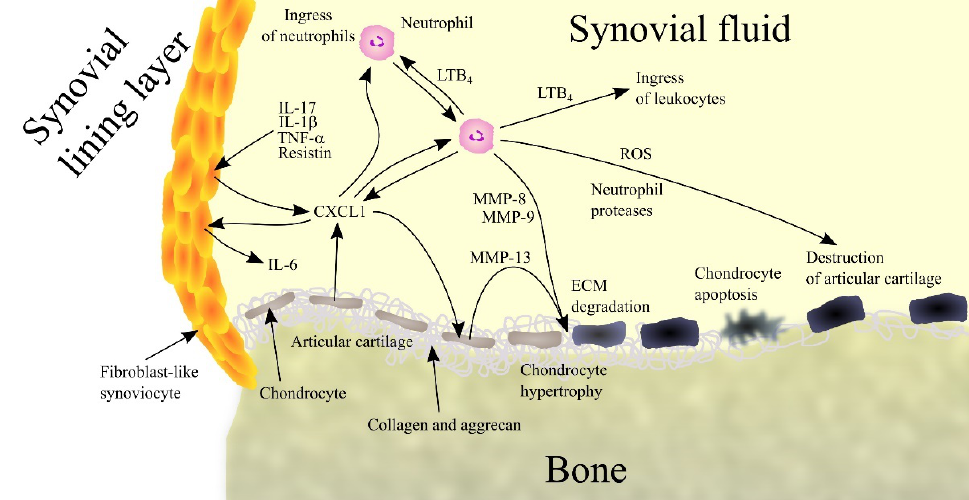
Figure 1. Importance of CXC motif chemokine ligand 1 (CXCL1) and neutrophils in rheumatoid arthritis. Patients with rheumatoid arthritis have elevated levels of interleukin-1 β (IL-1 β ), tumor necrosis factor α (TNF- α ), interleukin-17 (IL-17) and resistin in synovial fluid. These factors induce CXCL1 expression in fibroblast-like synoviocytes (FLS), chondrocytes and neutrophils, which leads to an increase in CXCL1 levels in synovial fluid. CXCL1 causes an increase in interleukin-6 (IL-6) expression in FLS. This chemokine causes leukotriene B 4 (LTB 4 ) synthesis in neutrophils and thus an ingress of more neutrophils and leukocytes into the joints. CXCL1 also causes an increase in matrix metalloproteinase-13 (MMP-13) expression in chondrocytes, which leads to extracellular matrix (ECM) articular cartilage degradation. Also responsible for this process are matrix metalloproteinase-8 (MMP-8) and matrix metalloproteinase-9 (MMP-9) produced by neutrophils. CXCL1 also causes chondrocyte hypertrophy and apoptosis. Finally, neutrophils secrete reactive oxygen species (ROS) and neutrophil proteases into synovial fluid. All these processes and factors lead to the destruction of articular cartilage and symptoms of rheumatoid arthritis. Abbreviations: CXCL1—CXC motif chemokine ligand 1; ECM—extracellular matrix; IL-1 β —interleukin-1 β ; IL-6—interleukin-6;